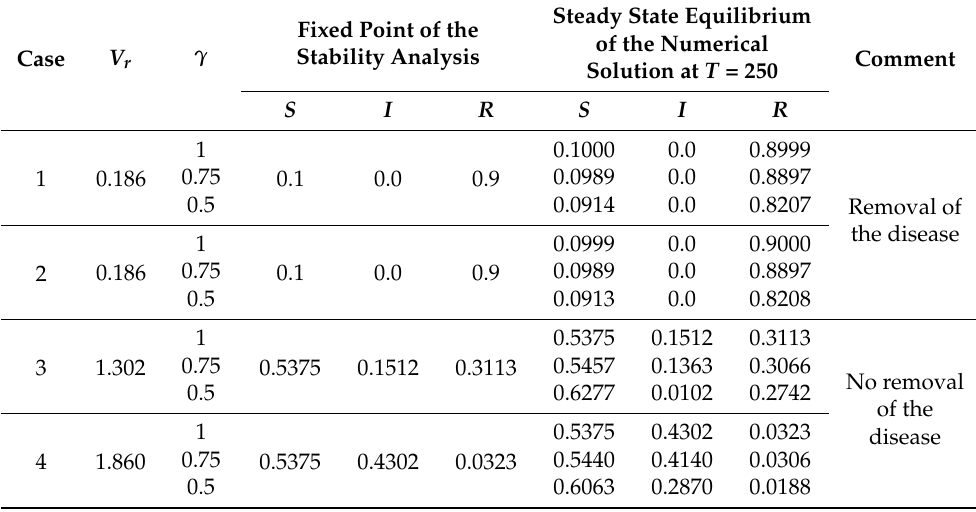
Table 1. Impact of various parameter values on the population fractions.